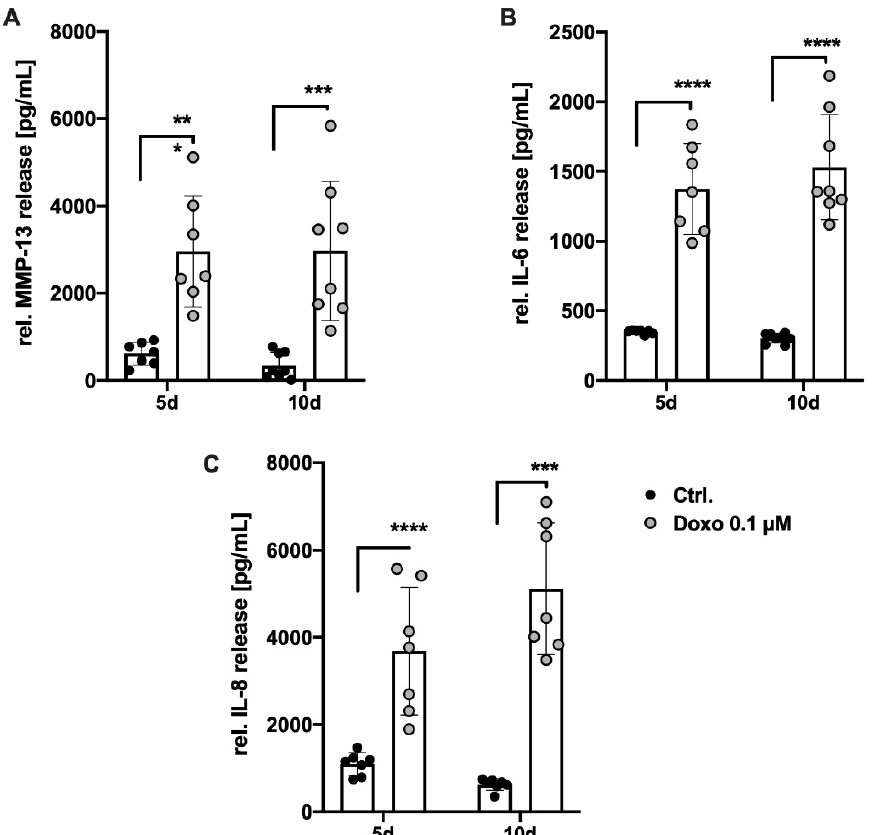
Figure 3. Influence of Doxo stimulation on the release of SASP factors in hAC. Secretion of ( A ) MMP-13, ( B ) IL-6, and ( C ) IL-8 into the culture media after 5 d and 10 d of Doxo stimulation was quantified by means of specific ELISAs. Data are presented as scatter plot with bars, mean with standard deviation. Significant differences between groups are depicted as: **** p ≤ 0.0001; *** p ≤ 0.001; ** p ≤ 0.01; * p ≤ 0.05. Statistical analysis: ( A – C ) Multiple t -test. Ctrl = control (unstimulated cells), rel. = relative.